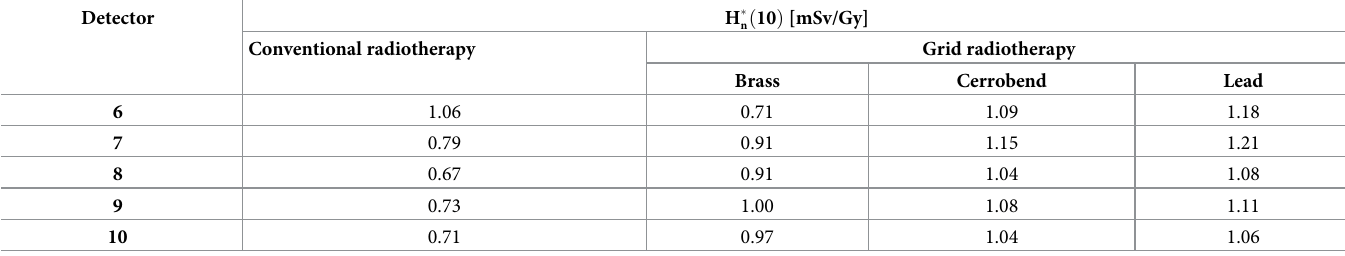
Table 2. Neutron ambient dose equivalent, H �